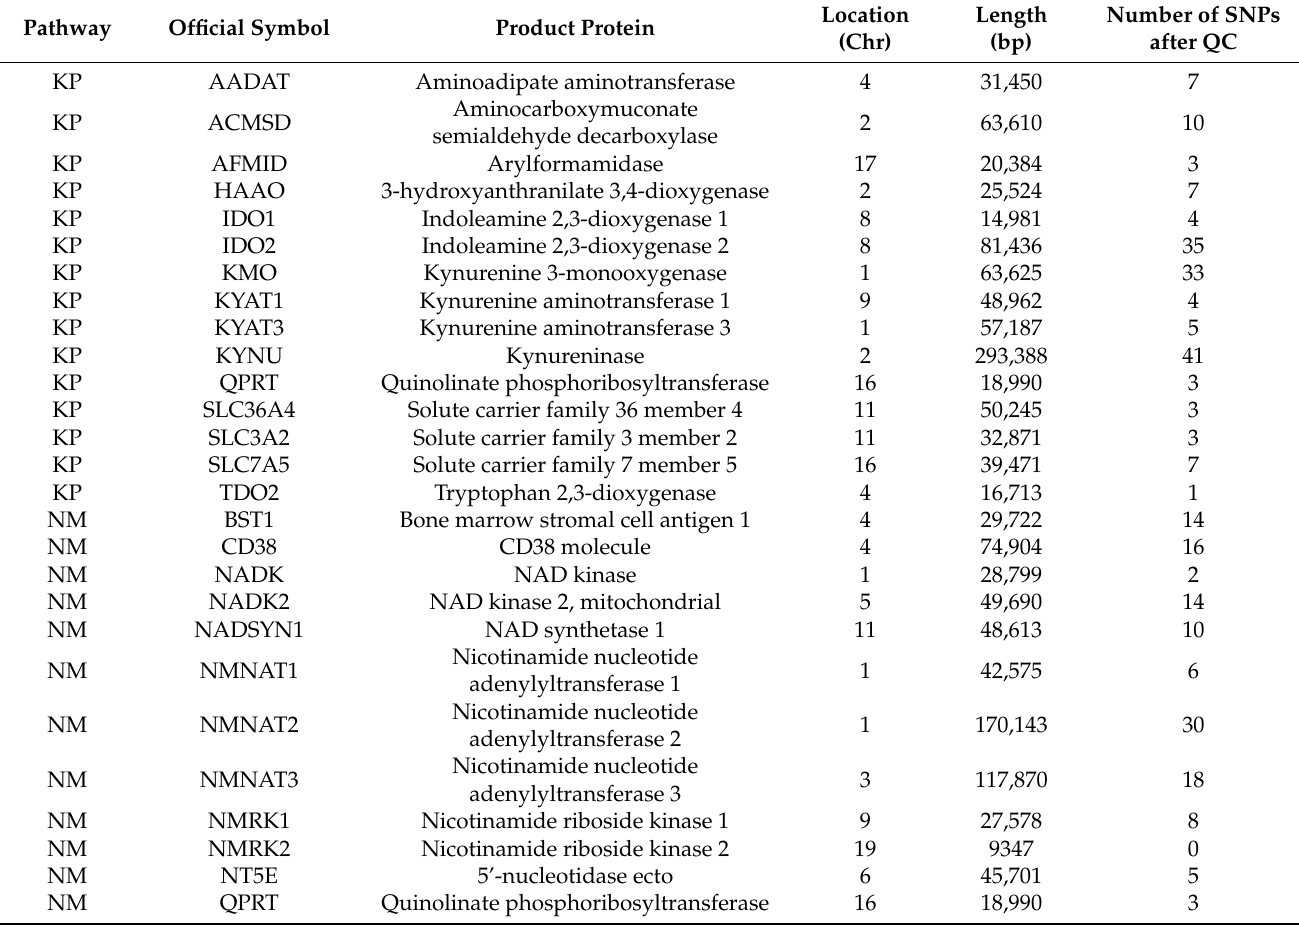
Table 1. Candidate genes information in kynurenine pathway & nicotinate